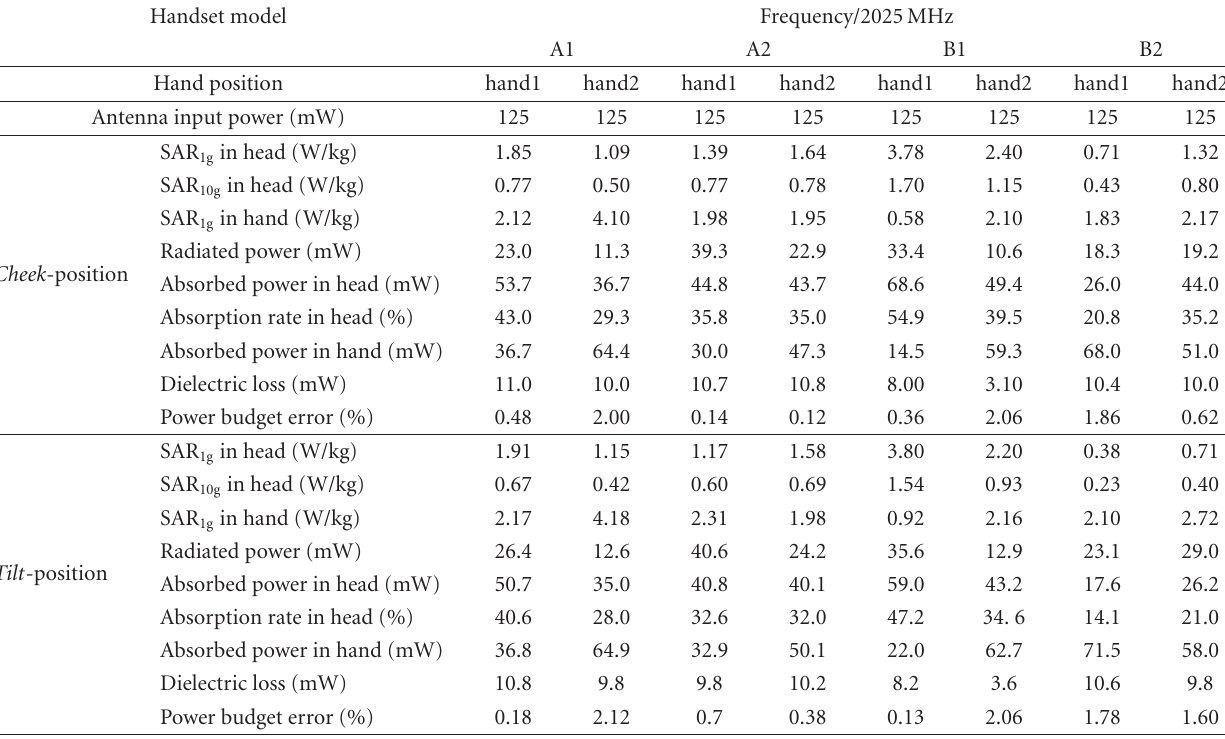
Table 10: Pooled statistics of peak 1 and 10g SAR in tissues, radiated power, absorbed power in tissues, dielectric loss, and power budget error for the handset models in hand closed to HR-EFH at di ff erent positions operating at 2025